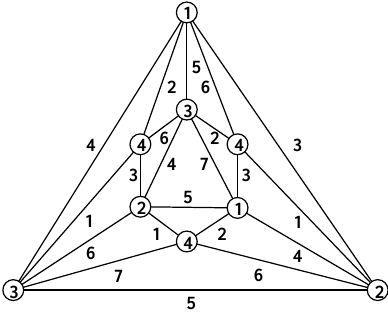
Figure 7. A total 7-coloring of J 9 .